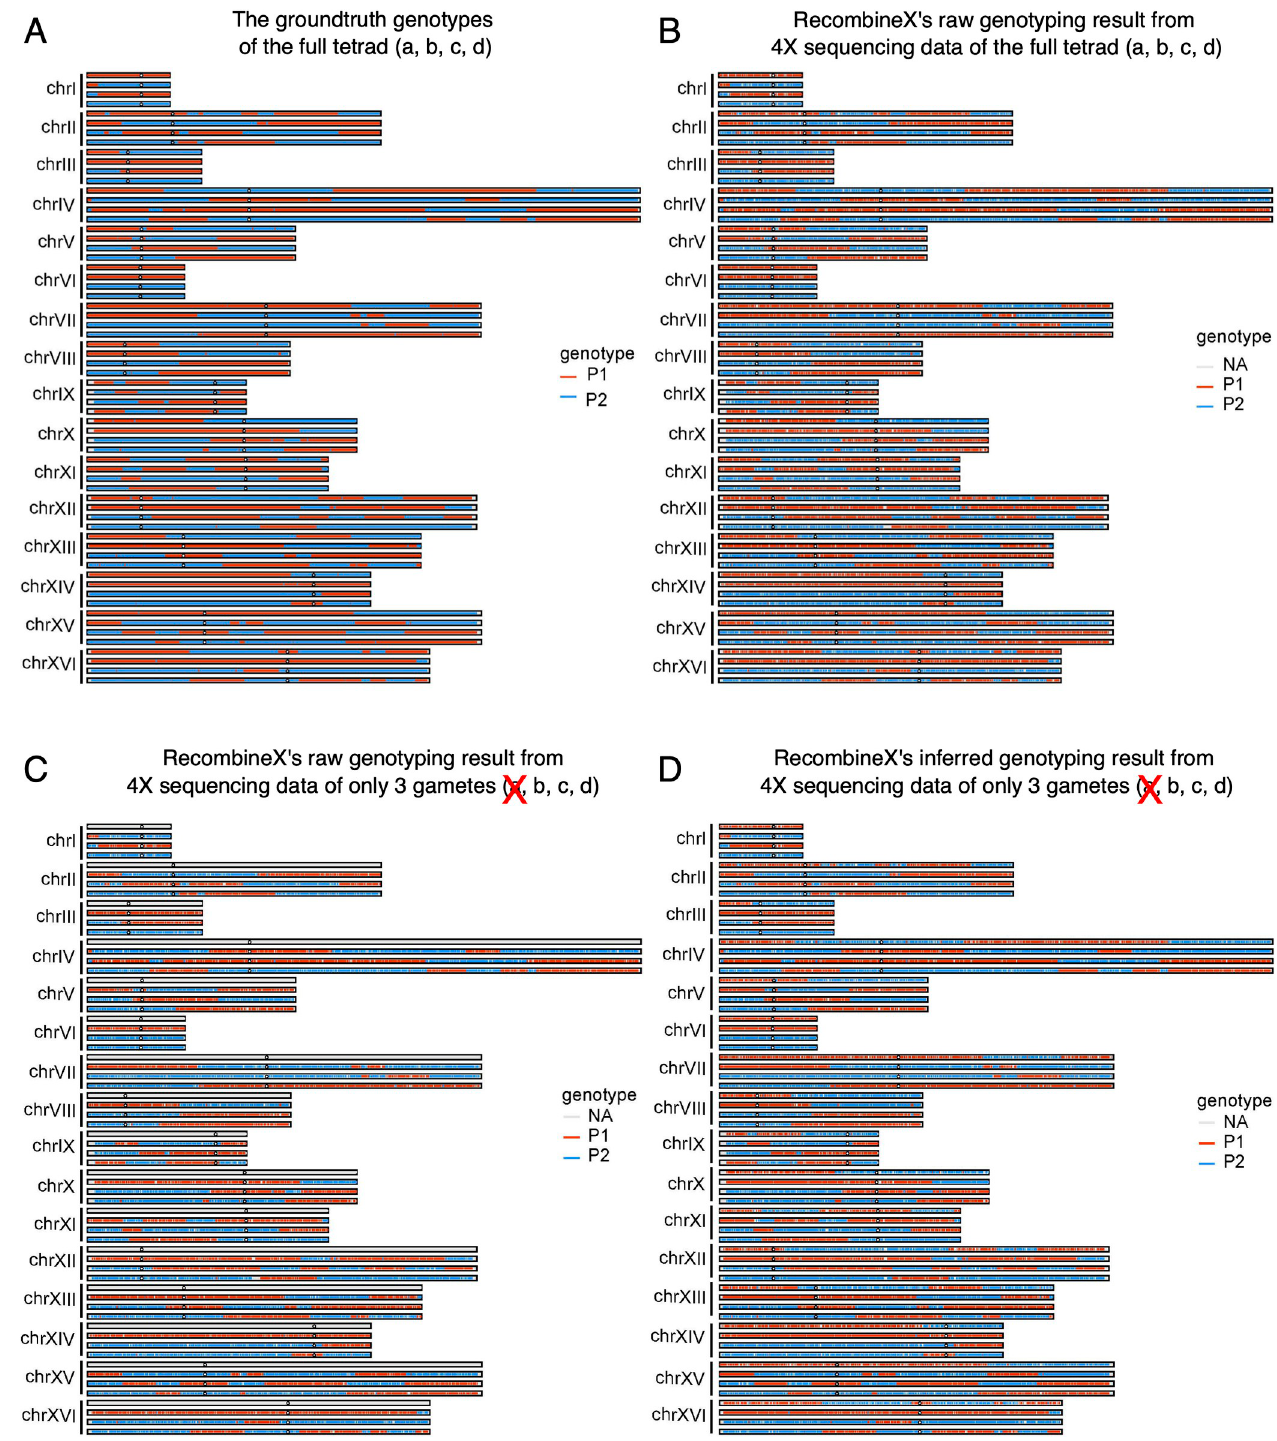
Fig 3. Performance of raw and inferred gamete genotyping with RecombineX. (A) The ground truth genotypes of the simulated tetrad (a, b, c, d). (B) RecombineX’s raw genotyping result for the simulated tetrad based on 4X sequencing data with a Q net cutoff of 30. (C) The raw genotyping result for the simulated tetrad based on 4X sequencing data of only three gametes (b, c, d) with a Q net cutoff of 30. (D) The inferred genotyping result for the simulated tetrad based on 4X sequencing data of only three gametes (b, c, d) with a Q net cutoff of 30.